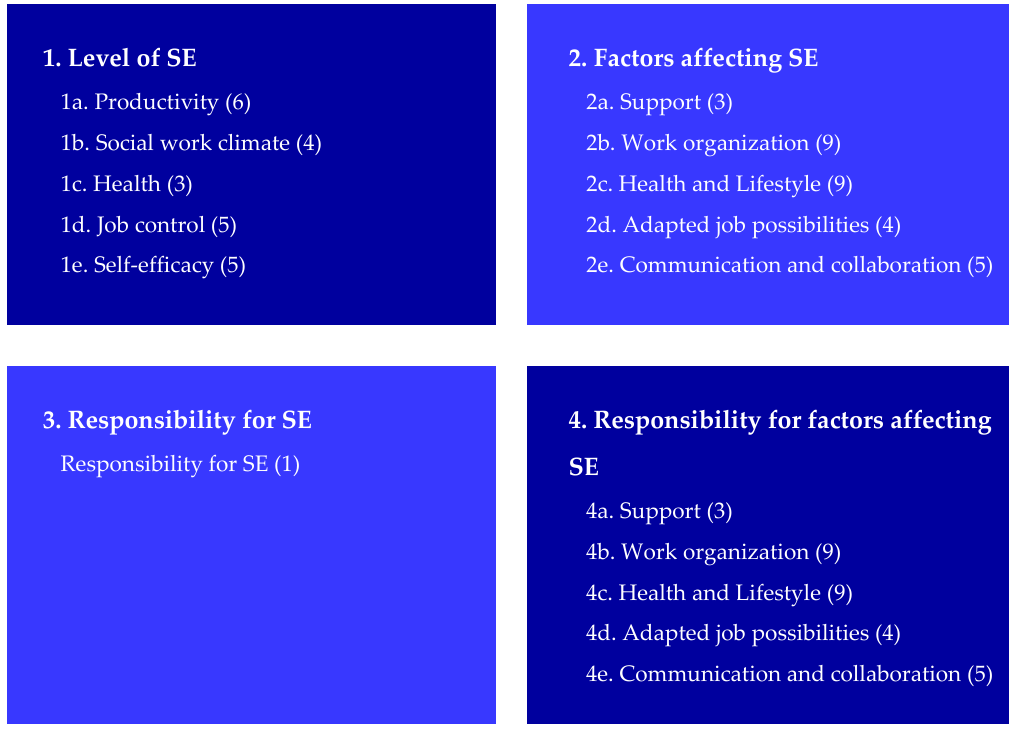
Figure 1. Areas, scales and number of items per scale of the MAastricht Instrument of Sustainable Employability (MAISE-NL) adapted for employees in low-skilled jobs (MAISE-Easy).